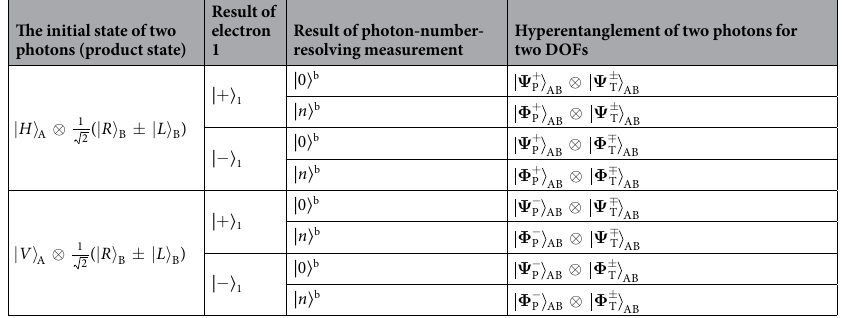
Table 1. The generated hyperentanglement having its own correlations for two DOFs (polarization and time- bin) on two photons, according to the initial state, the results of electron spin 1 in QD and photon-number- resolving measurement of the quantum bus beam on path